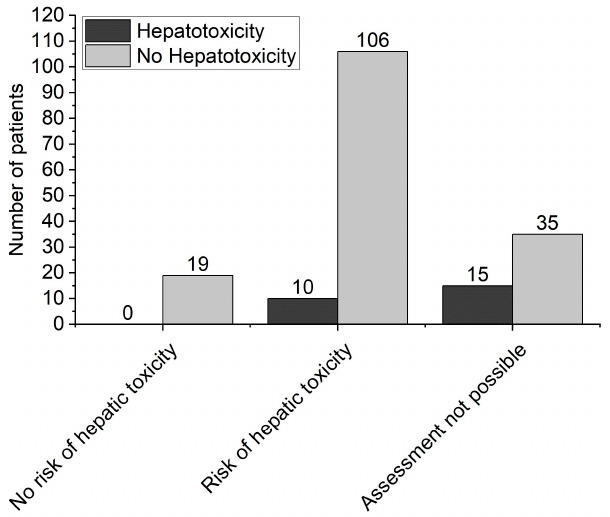
Figure 1. The relationship between assignment to hepatotoxicity risk assessed by means of the Rumack-Matthew nomogram (“risk”, “no risk” and “assessment not possible” on the horizontal axis) and hepatotoxicity (group C), determined on the basis of plasma aminotransferases measurement.